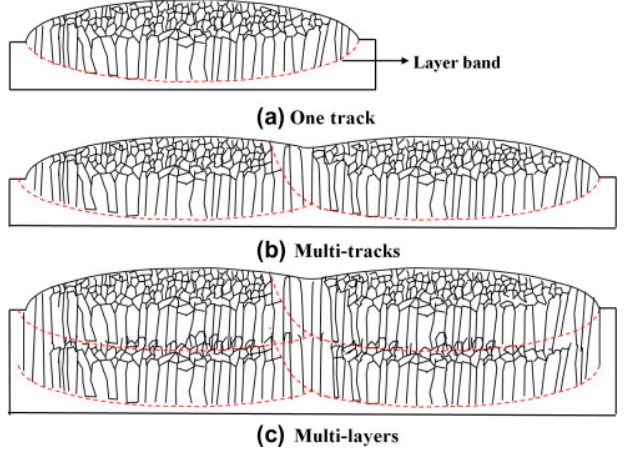
Figure 27. Schematic illustration of the microstructural evolution during the LP-DED process, ( a ) One-track, ( b ) Multi-track, and ( c ) Multi-layers (reproduced with permission from [132]; Copyright © 2013 Elsevier).